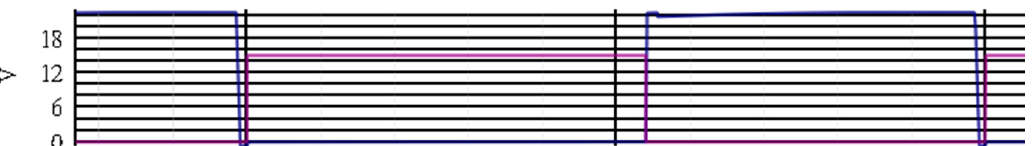
Figure 10. Simulation waveform.